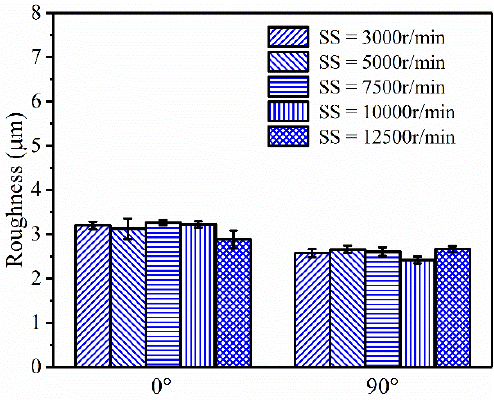
Figure 11. Roughness of PEEK samples under different SS (LT = 0.1 mm, DOC = 0.2 mm, FRT = 0.02 mm).